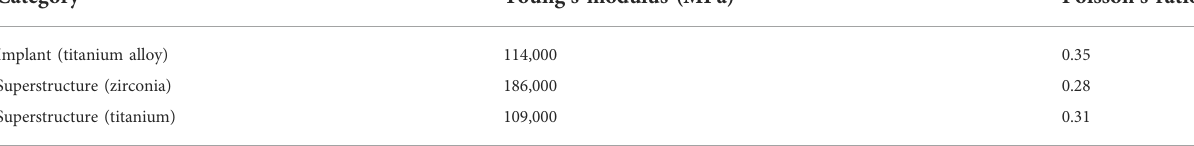
TABLE 2 Mechanical properties of the materials of implant and superstructure.